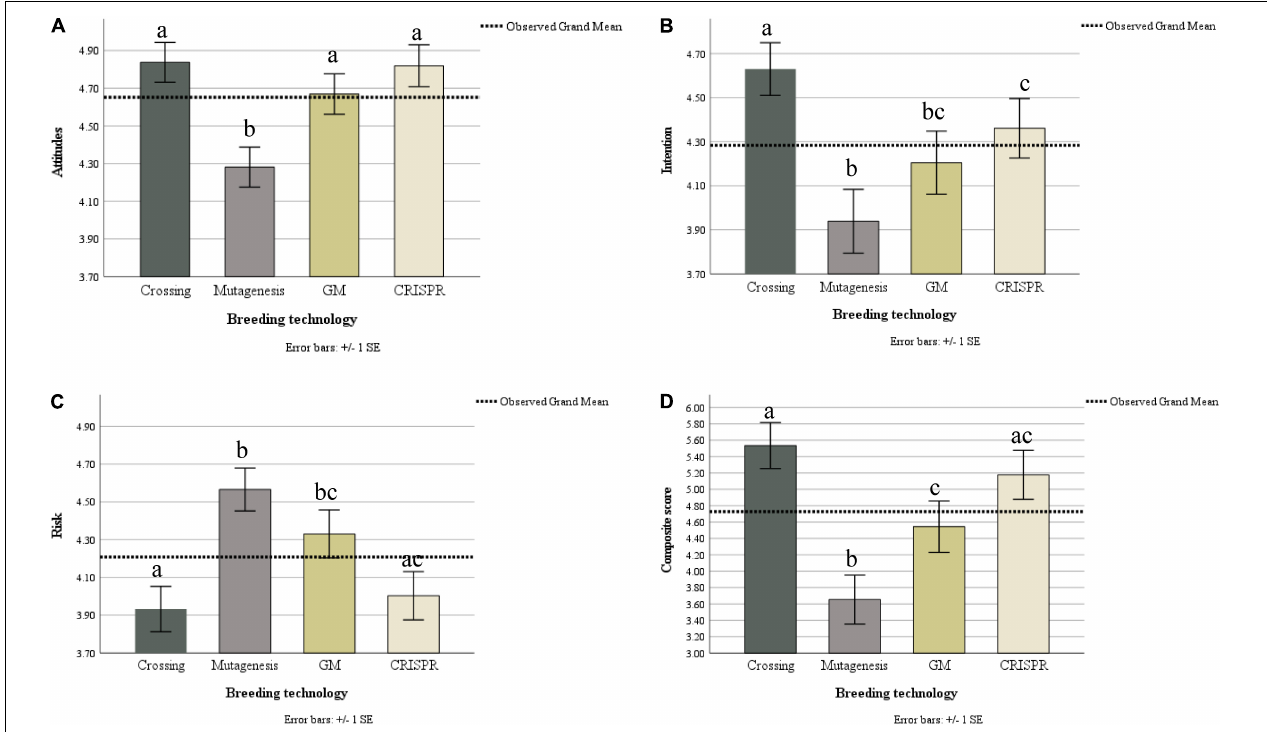
FIGURE 1 | Illustration of differences between the four breeding technologies across the three variables and a composite score (all three variables combined). Different letter indicates that the means differ significantly within a panel in Bonferroni-corrected pairwise comparisons. Results in Panel (B) are Greenhouse-Geisser corrected. Results in panels A , C , and D met the assumption of